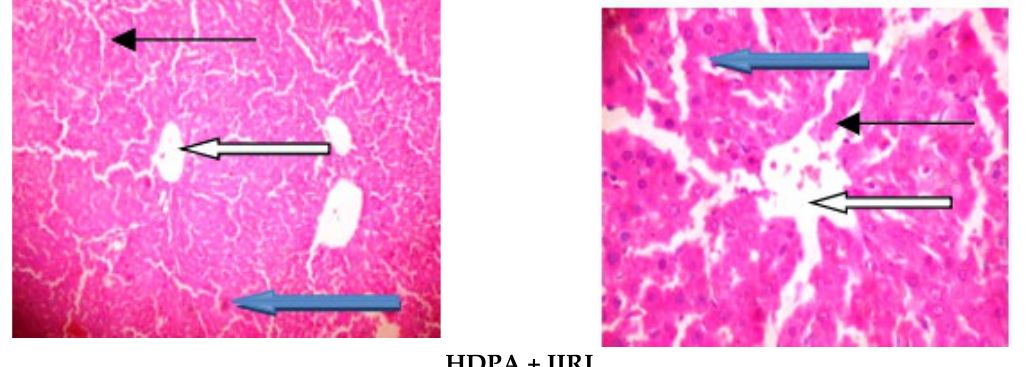
Figure 6. Effect of intestinal ischemia/reperfusion (I/R) and methanolic Phyllanthus Amarus leaf extract on hepatic histoarchitecture. IIRI: intestinal ischemia/reperfusion injury, FEB: febuxostat, LDPA: low-dose Phyllanthus Amarus, HDPA: high-dose Phyllanthus Amarus. The sham-operated animals showed normal central venules (white arrow) and normal hepatocytes (blue arrow), and the sinusoids also appeared normal (slender arrow). No pathological lesions were seen. Animals in the IIRI group showed normal central venules (white arrow), mild congestion of the portal vein (black arrow), some degenerated hepatocytes (blue arrow), and some necrotic hepatocytes (red row). The sinusoids appeared normal (slender arrow). The rats in the FEB + IIRI group showed normal central venules without congestion (white arrow). The hepatocytes appeared normal (blue arrow), and the sinusoids appeared normal without being infiltrated by inflammatory cells (slender arrow). Animals in the LDPA + IIRI group showed normal central venules (white arrow), and the hepatocytes (blue arrow) and sinusoids (slender arrow) appeared normal. The rats in the HDPA + IIRI group showed normal central venules (white arrow). The hepatocytes appeared normal (blue arrow), and the sinusoids also appeared normal and not infiltrated (slender arrow).